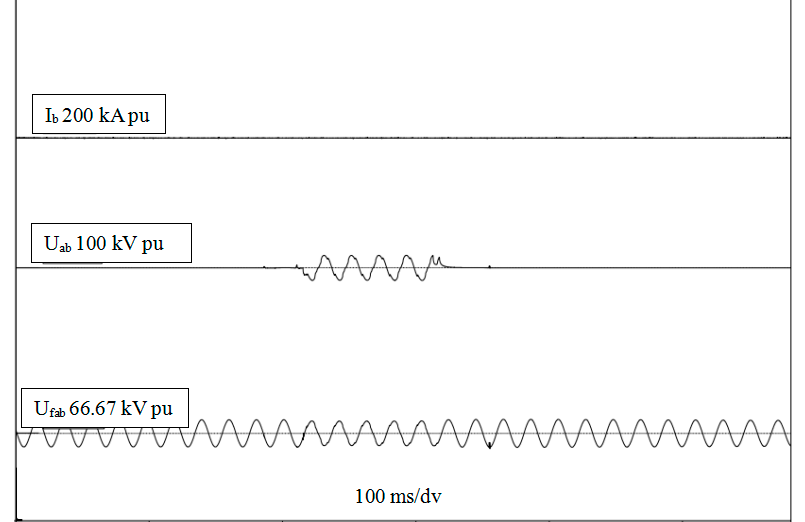
Figure 17. Current waveform of the short circuit.